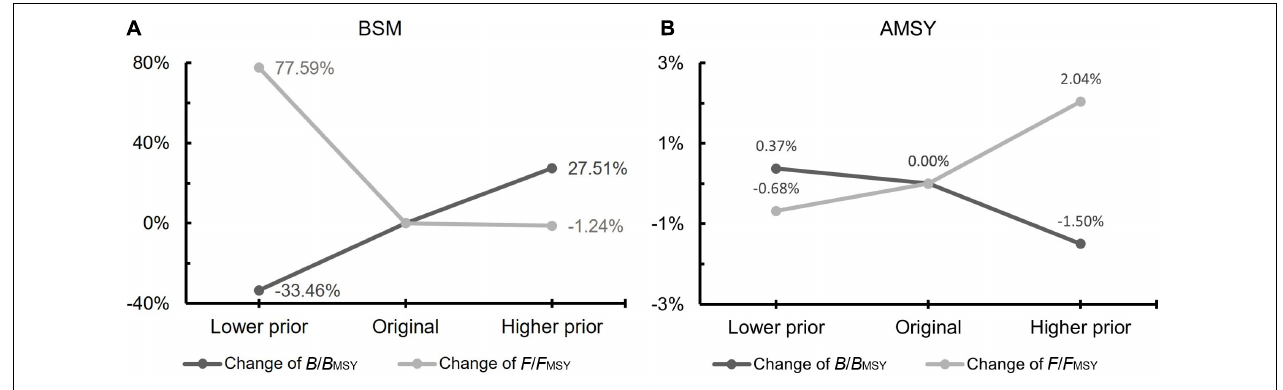
FIGURE 7 | Sensitivity of B/B MSY and F/F MSY to changes of the priors. (A) BSM; (B) AMSY.